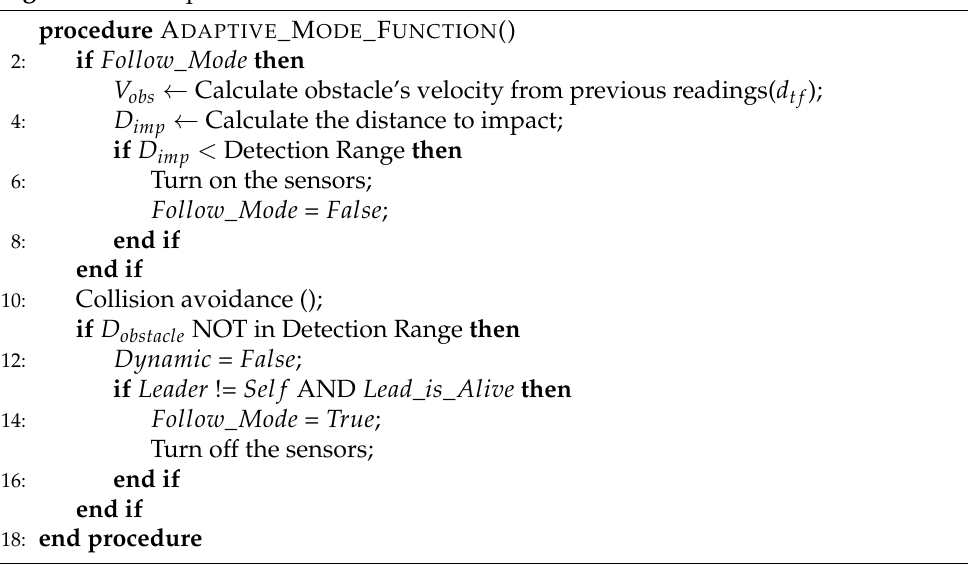
Algorithm 6 Adaptive Mode